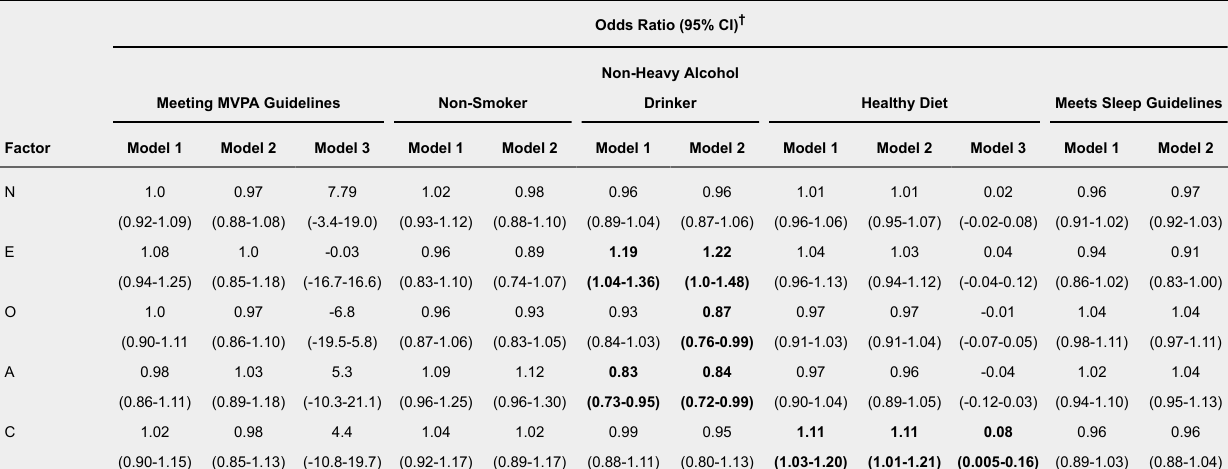
Multivariable Logistic Regression Association Between Personality Type and Individual Health